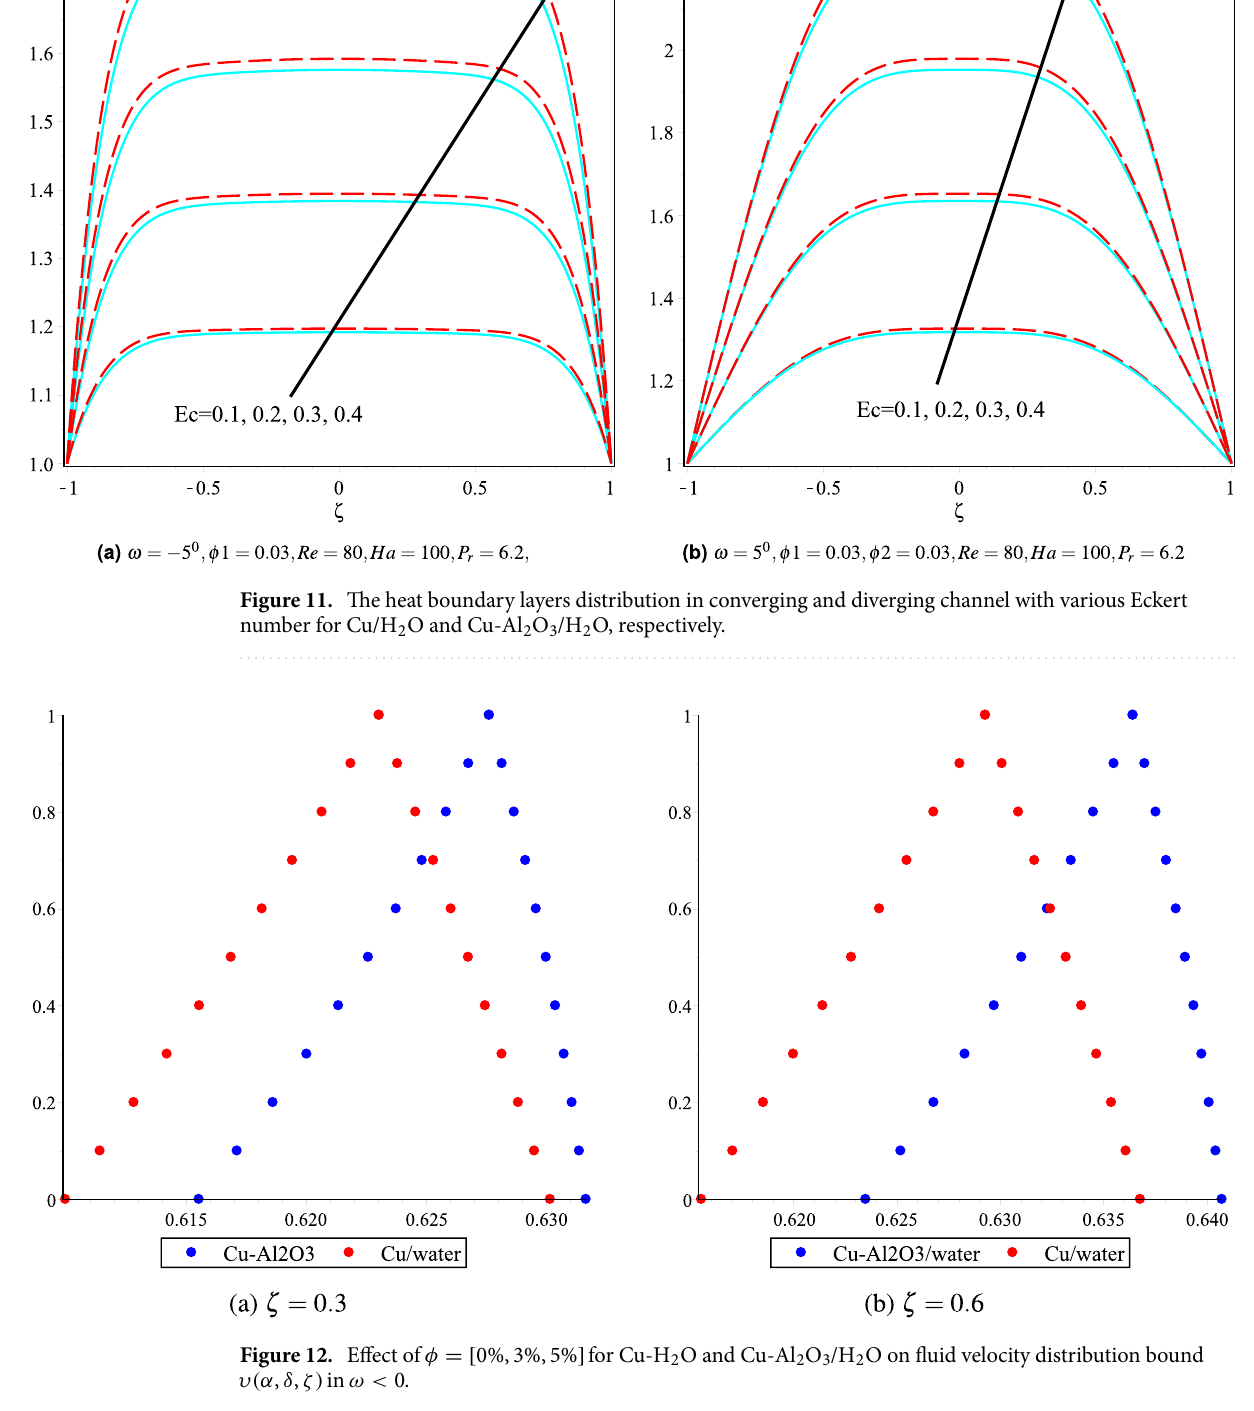
Figure 9a,b depicts the effect of the Hartmann number on the fluid veloc- ity for Cu and Cu-Al 2 O 3 /H 2 O nanoparticles in ω > 0 and ω < 0 channels. It can be seen that upon increasing the Hartmann number raises the velocity of the fluid for both ω > 0 and ω < 0 channels. While Fig. 10a,b depicts the variation in fluid temperature for both channels with different values of Hartmann number and keeping other parameters fixed. It can also be observed that a more significant Harmann number raises the fluid temperature for both ω > 0 and ω < 0 channels. Physically, the dominant magnetic field increases the viscous forces, resulting in increased resistance and, as a result, increases the heat production in the fluid. As a result, in